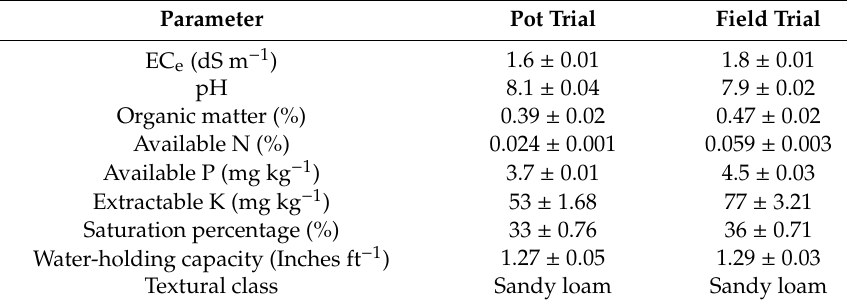
Table 2. Characteristics of the soils; values are the mean of three replications ±